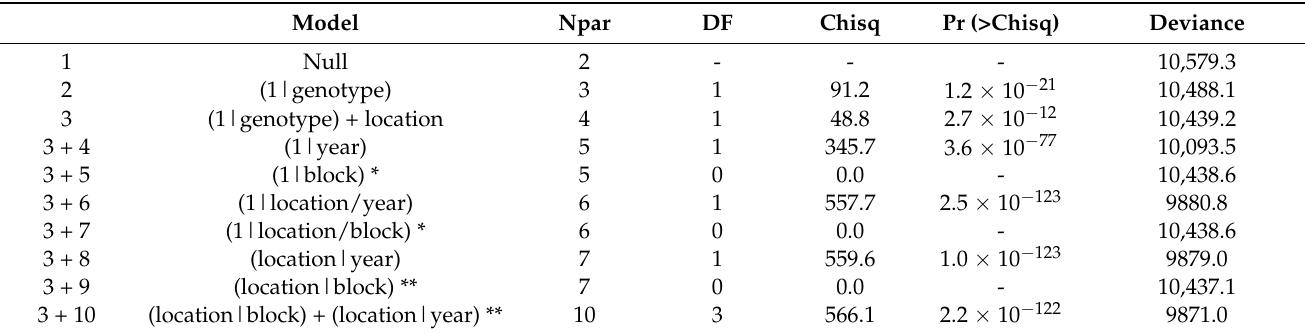
Table 1. Summary of ANOVA to simplify models with good-fit statistics on 43 coffee genotypes ( Coffea canephora ) for yield evaluated in two locations and four years.